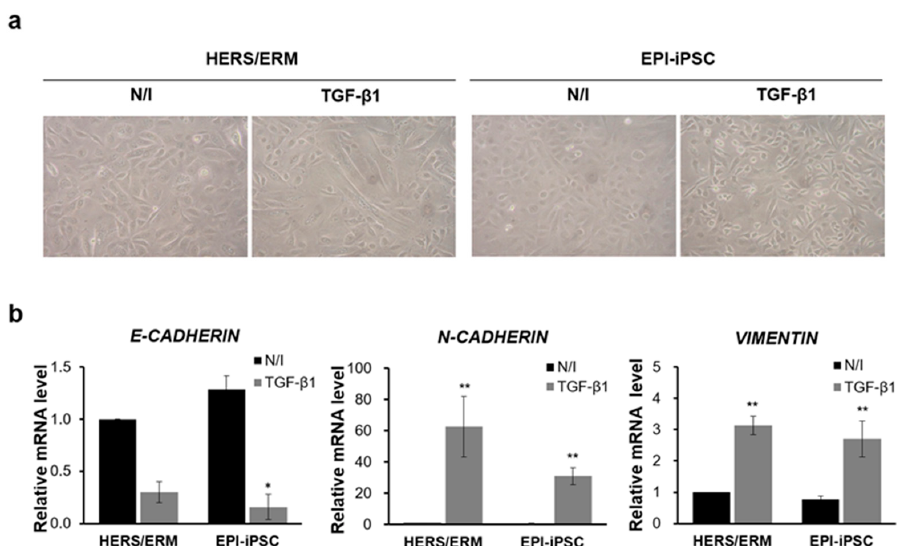
Figure 5. Epithelial-mesenchymal transition (EMT) of HERS / ERM cells and the EPI-iPSC cell line. The EMT was induced by TGF- β 1 for 48 h. ( a ) Morphology of the EPI-iPSC cell line after 48 h of TGF- β 1 treatment. All of these cells lost epithelial cell polarity and cell-to-cell contact. ( b ) EMT-related gene expression of the EPI-iPSC cell line after EMT induction. When all cell types were treated with TGF- β 1, the gene expression of N-cadherin and Vimentin was increased in primary HERS / ERM and epithelial-like cells. However, the levels of E-cadherin were decreased. All data shown are the mean ± S.D. from the levels of three replicates. Data are presented as the mean ± SD, n = 6 per group. ** p < 0.01, * p < 0.05. N/I: no induction.